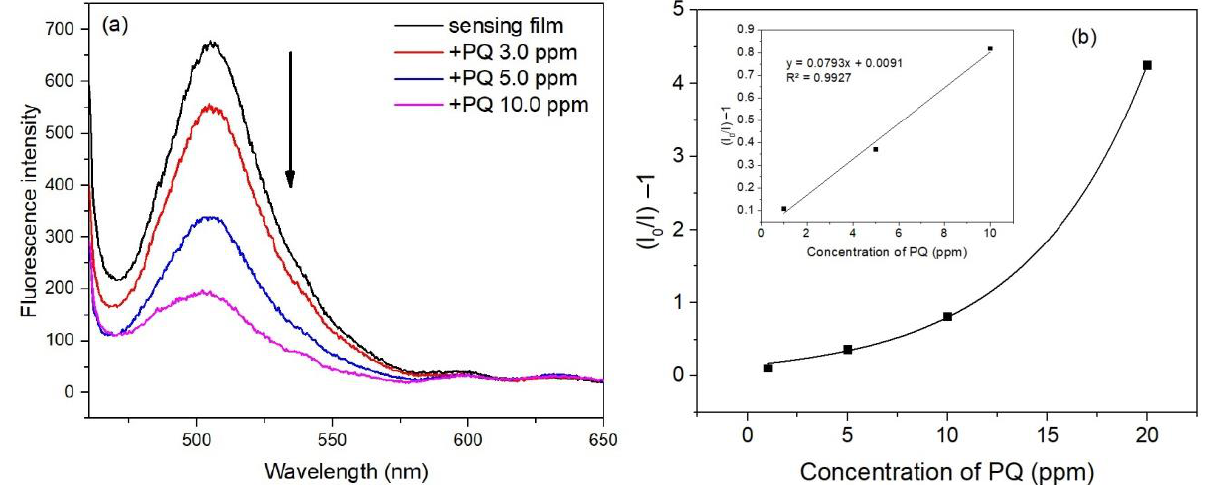
Figure 9. Responses of the sensing film to PQ ( a ) and a Stern–Volmer plot for PQ quenching of sensing films, inset: a linear relationship in the concentration range 1–10 ppm ( b ).